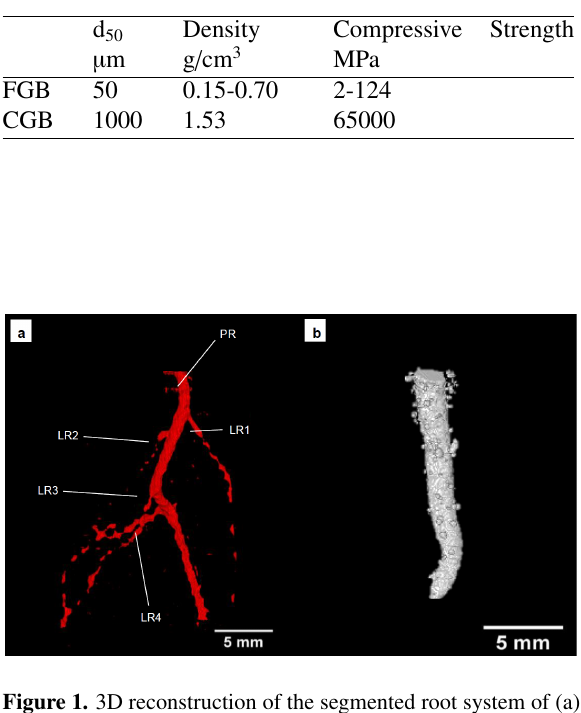
Figure 1. 3D reconstruction of the segmented root system of (a) the coarse glass beads sample with each type of root indicated (PR, primary root; LR1, lateral root 1; LR2, lateral root 2; LR3, lateral root 3; LR4, lateral root 4) and (b) the fine glass beads sample.